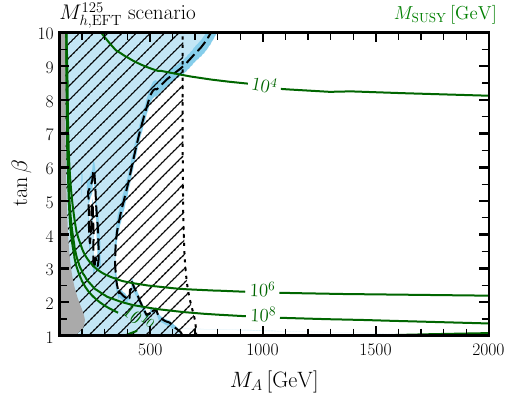
Fig. 1 The M 125 benchmark scenario shown in the ( M A , tan β) h , EFT plane. The green solid contour lines indicate the required SUSY scale. The blackdottedline and hatchedarea markstheparameterspacewhich is disfavored at the 2 σ level by the measured Higgs-boson signal rates. The blue region with the black dashed edge is excluded at the 95% C . L . byLHCsearchesforadditionalHiggsbosons(the darkblueband shows howthetheoreticalrateuncertaintyaffectstheexclusion).The grayarea is excluded because the mass of the SM-like Higgs boson h is below 122GeV